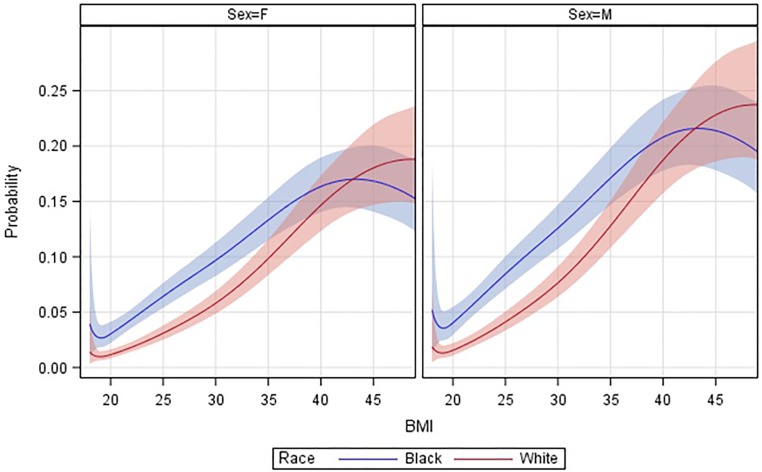
Plots of estimated 5-year probabilities of incident medication-treated diabetes during mean follow-up by BMI according to race and sex1.1 Estimated 5-year probabilities of incident diabetes specific for a person who was enrolled at mean values of enrollment age, alcohol drinks per day and total physical activity MET-hours, and modal values for other categorical covariates, with cubic spline knots at BMI 20, 30 and 40 kg/m2; Shaded bands about the curves represent 95% confidence limits on the estimated probabilities.